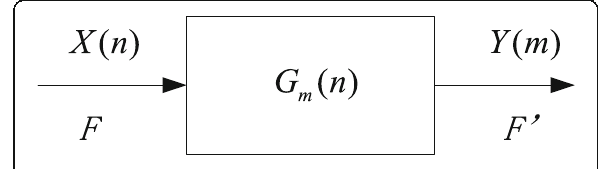
Fig. 2 Sampling rate conversion block